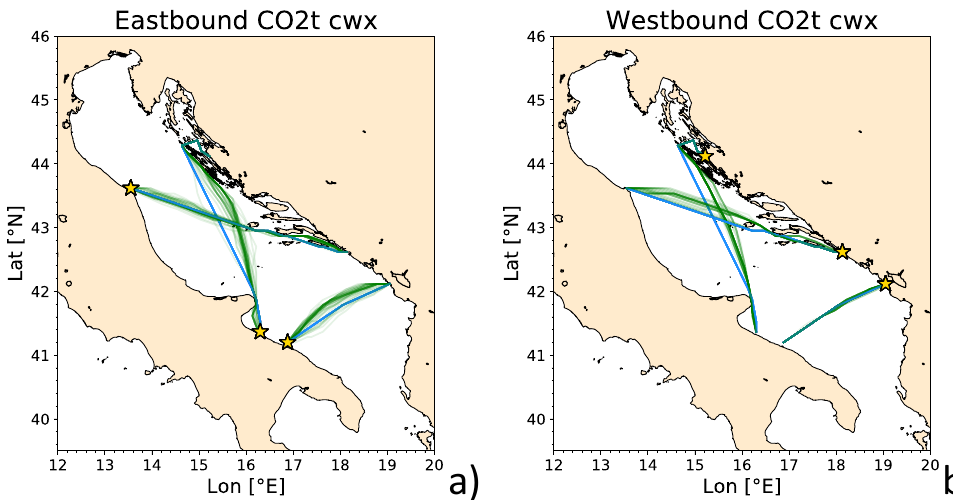
Figure 5. Bundles of least-CO 2 routes considering both waves and currents for three crossings in the Adriatic Sea. ( a ) Eastbound ( b ) Westbound routes. All routes for variable departure times and engine loads for 25 January 2019 are